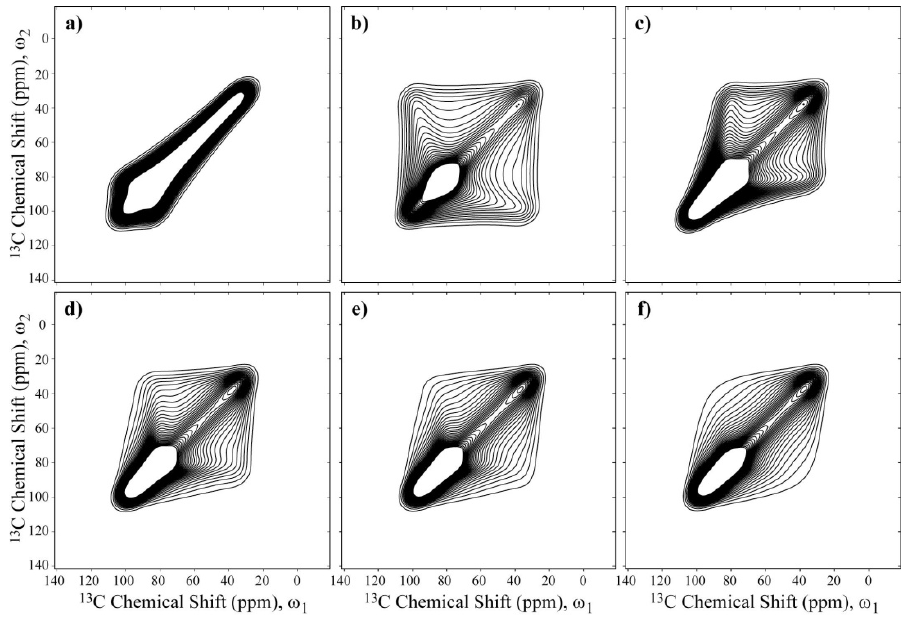
Figure 5. Simulations of 2D Exchange NMR spectra considering a Gaussian distribution of rotation angles with a root-mean-square angle of 60°. Rotations around the ( a ) σ ; and ( c ) σ principal axes, and around axes ( d ) 30°; ( e ) 40°; and ( f ) 50° apart from ( b ) σ yy zz the σ principal axis. In these cases, the angle β corresponds to the Euler angle that relates zz the z -axis of the local chain and the PAS of the chemical shift